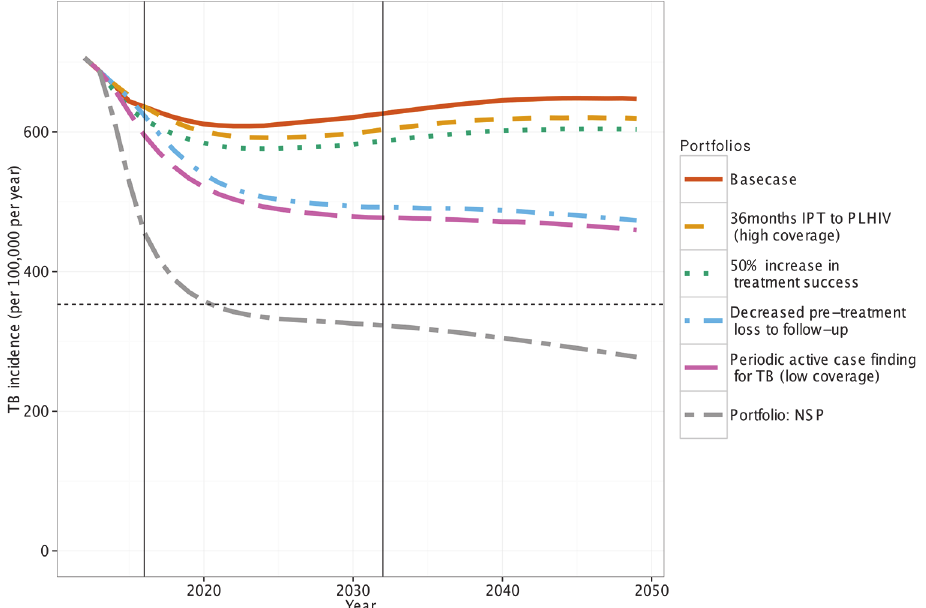
Fig 2. The impact of the intervention components of the “ NSP ” portfolio on TB incidence (/100,000/ year). The dashed horizontal line is the NSP 2016 target. The solid vertical lines show the timing of the NSP deadlines in 2016 and